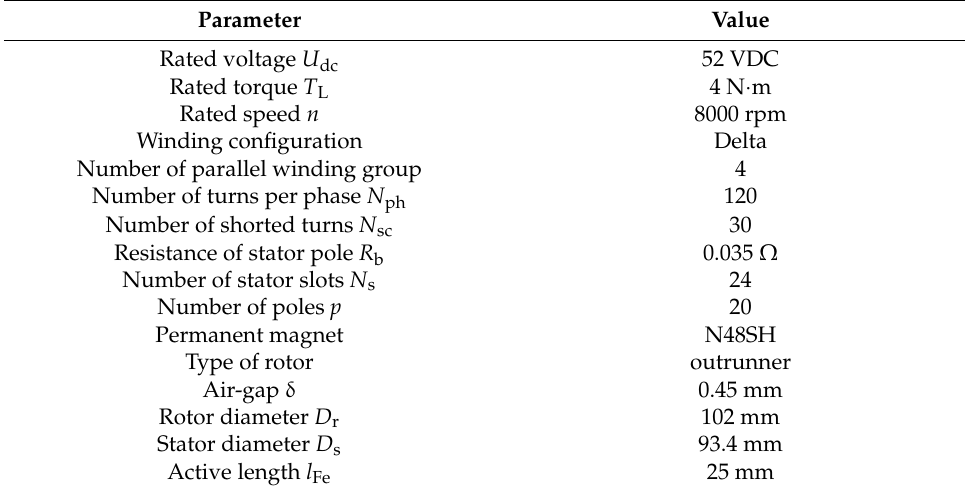
Figure 1. A hybrid drive system featuring a BLDC motor. Table 1. Selected parameters of motor for UAV